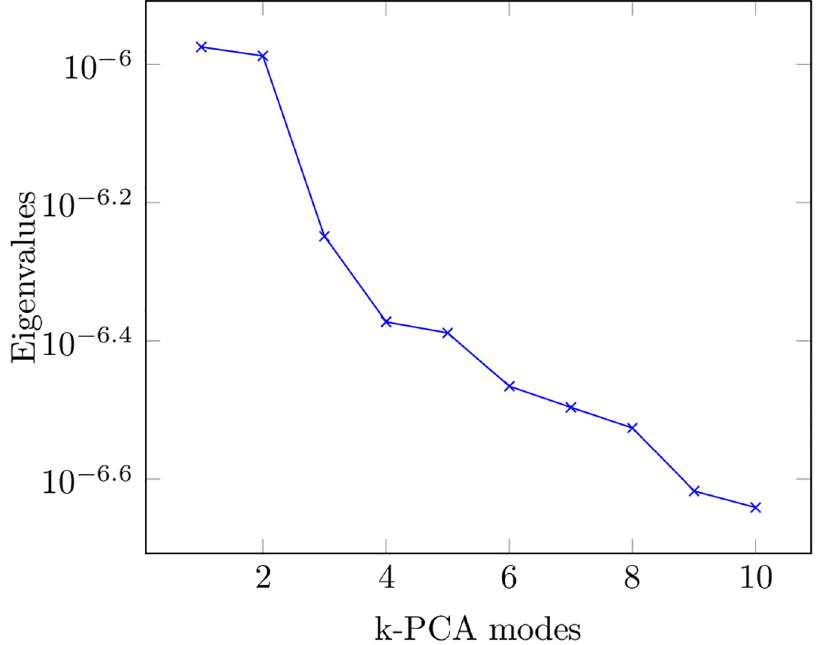
Fig 5. This picture represents the evolution of the eigenvalues for the first 10 k -PCA modes. We distinguish three modes that stand out with regard to the others. This fact justifies the reduction to the embedded manifold. As a result, we aim to provide with a more manageable and efficient system for